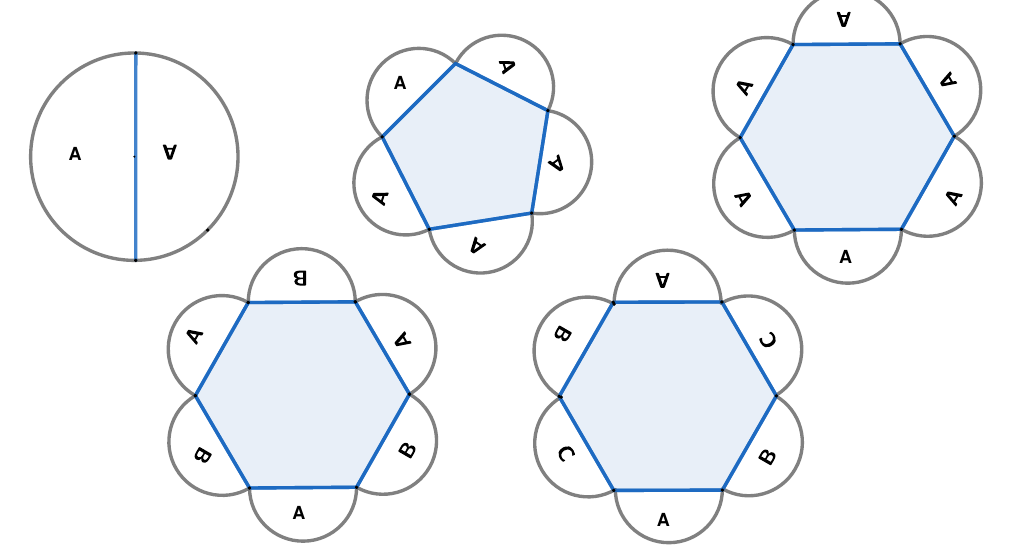
Figure 5 . The dissections invariant under some rotation for p = 5 it is clear that d = 1 ; 5 and are as shown in the (cid:12)rst two diagrams starting clockwise from the left corner. For p = 6 with d = 1 ; 2 ; 3 ; 6 and the invariant dissections are the ones shown in (cid:12)rst and last three diagrams of (cid:12)gure